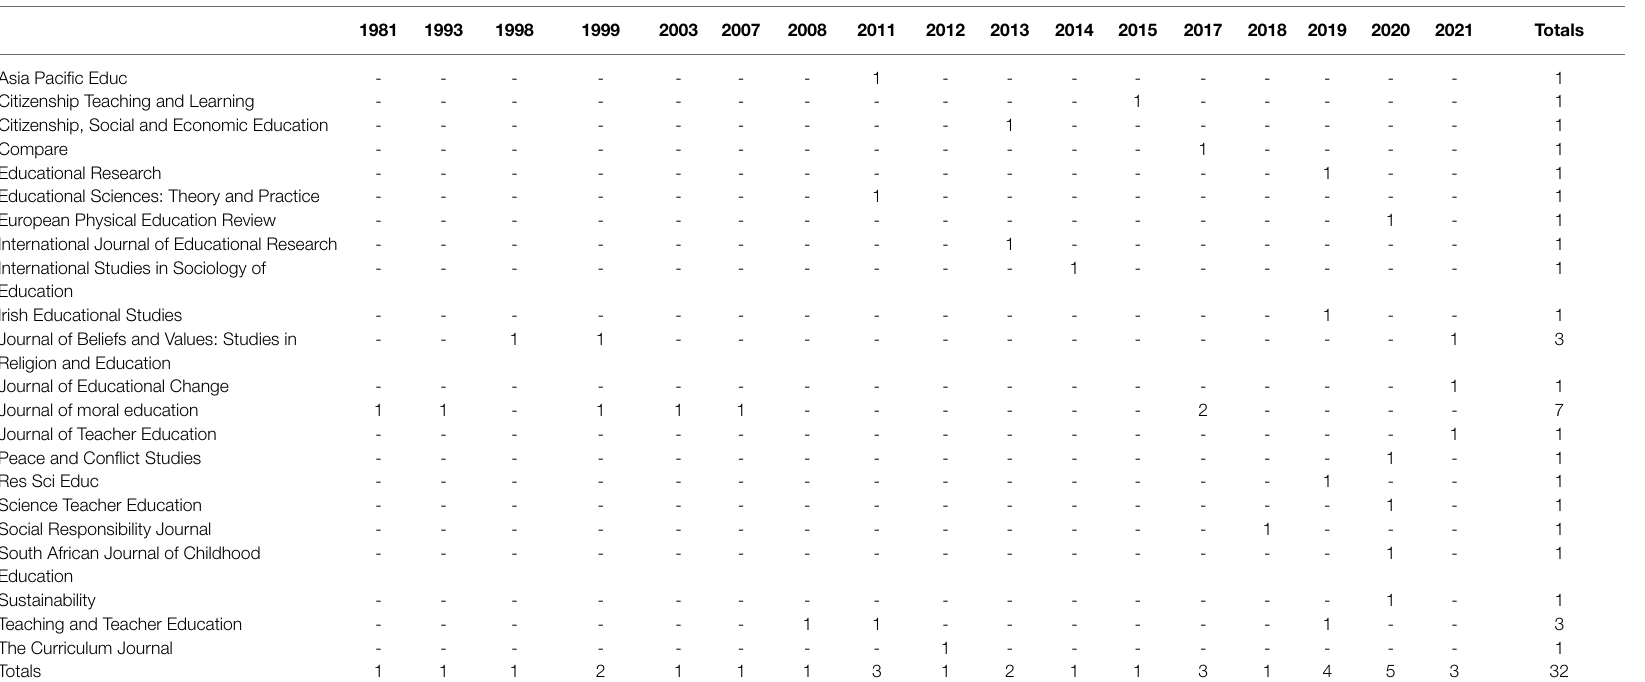
TABLE 2 | No. of articles according to the